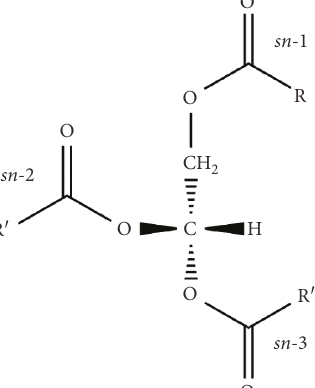
Figure 3: The Fisher projection of a triacylglycerol molecule with different acyl chains (R, R 2, and sn